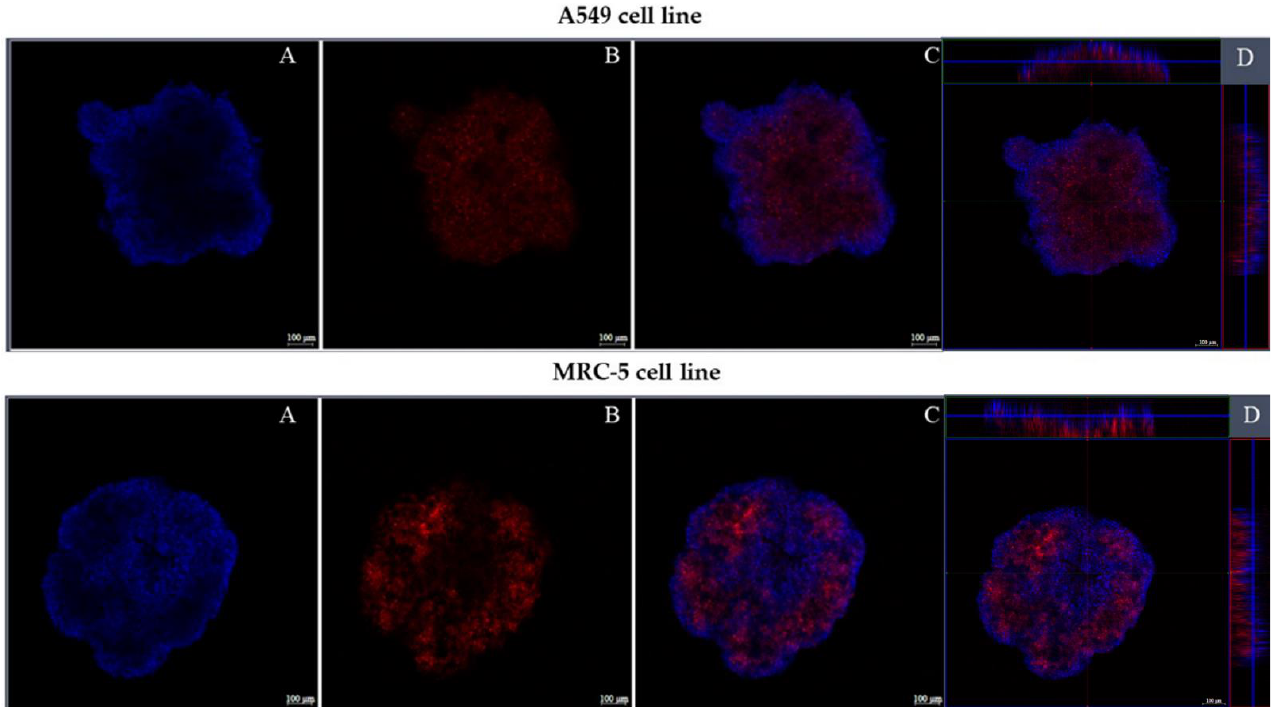
Figure 8. Fluorescence of three-dimensional cultures of lines A549 and MRC-5. ( A ) — the blue marking shows the nucleus of the cells; ( B ) — in red the cytoplasm of the cells; ( C ) — merge of the red and blue markings and ( D ) — shows the depth of the three-dimensional crops.